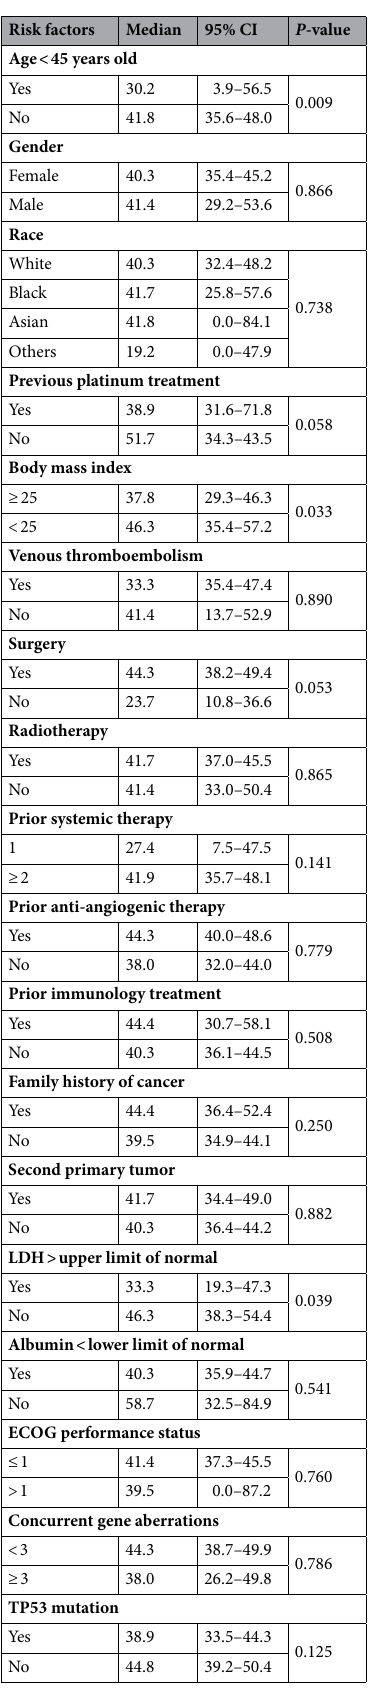
Table 2. Univariate analysis of risk factors for overall